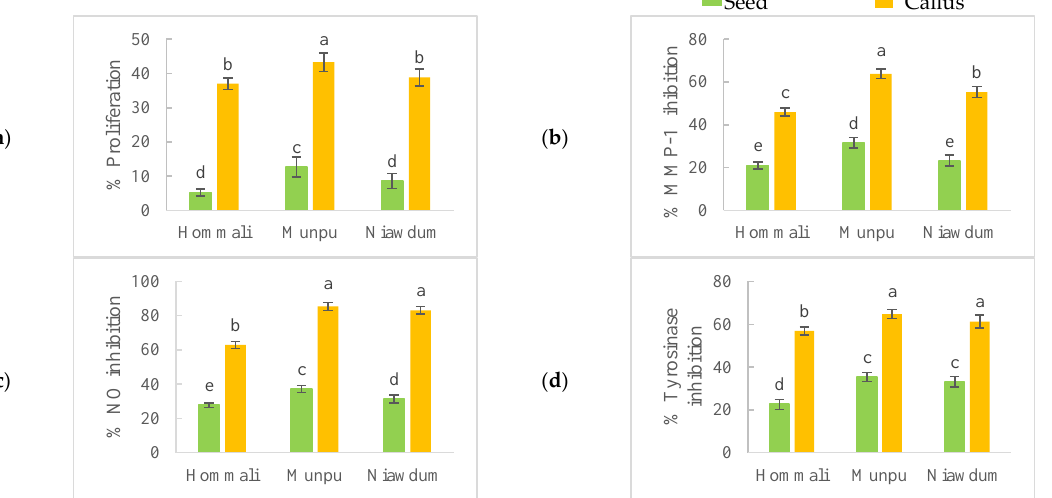
Figure 5. The anti-aging activities of rice callus and seed extracts including keratinocytes’ proliferation ( a ), anti-collagenase ( b ), anti-inflammatory ( c ), and anti-tyrosinase activities ( d ). Values are displayed as means ± SD ( n = 3). Data with different letters (a, b, c, d and e) indicate significant differences ( p < 0.05) between samples.